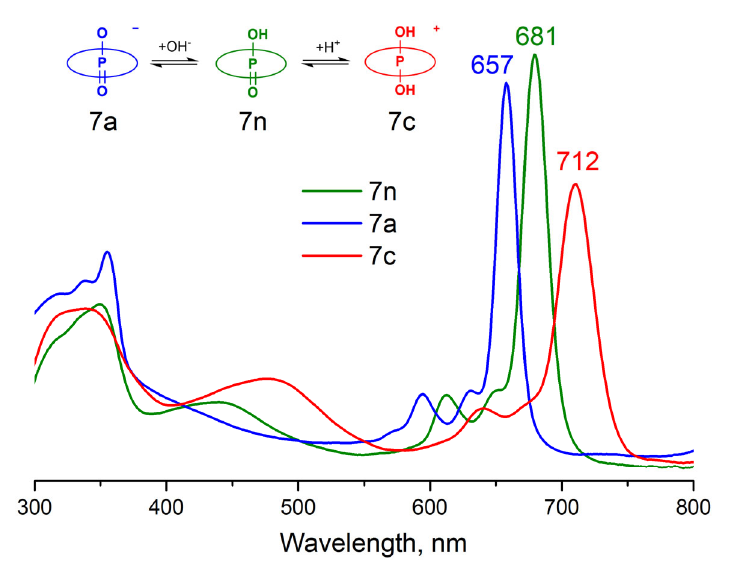
Figure 2. UV–vis spectra of different forms of compound 7 in DMSO.